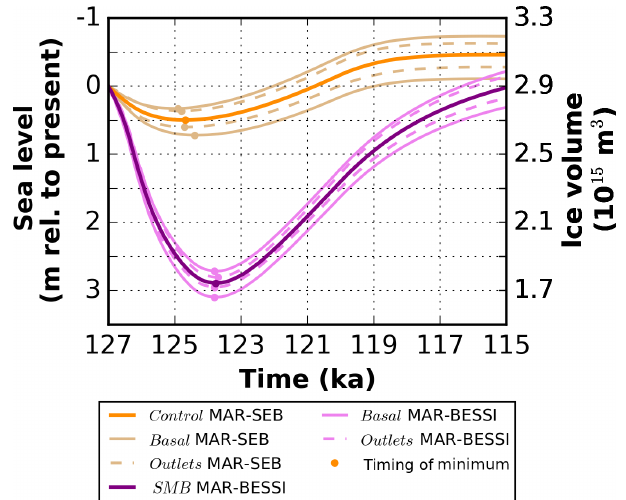
Figure 1. Evolution of the ice volume for the control (MAR-SEB, orange, bold) and the SMB (MAR-BESSI, purple, bold) experi- ments in comparison with the basal/outlets sensitivity experiments. The basal (friction × 0 . 9 / × 1 . 1 for the entire ice sheet) and outlets sensitivity experiments (friction × 0 . 5 / × 2 . 0 at the outlet glaciers) are indicated with thin solid and thin dashed lines, respectively. Note that the lower friction experiments give lower volumes. The minimum of the respective experiments is indicated with circles.